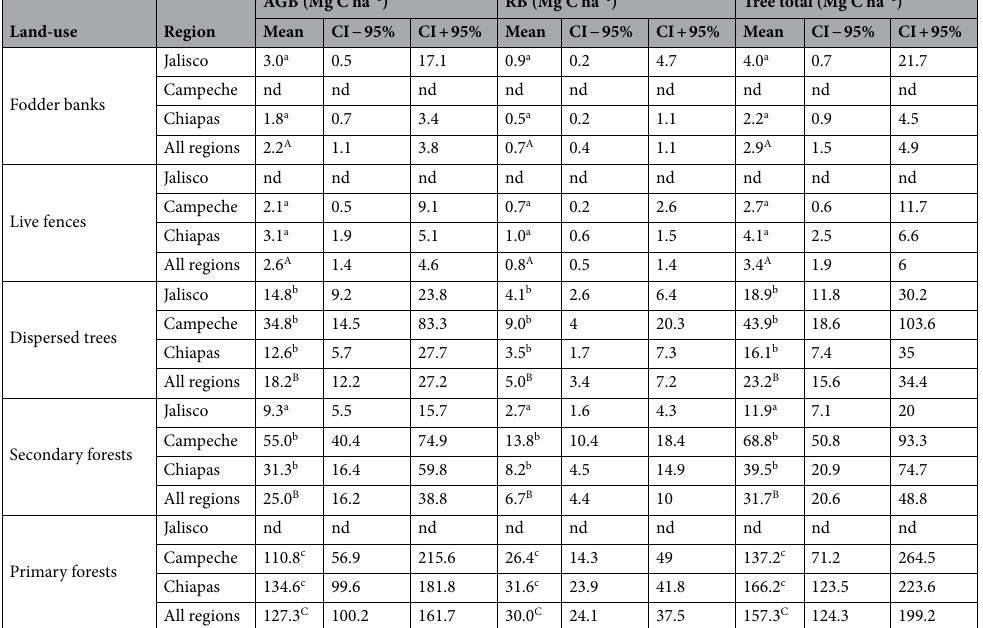
Table 2. Back-transformed weighted means and respective 95% confidence intervals of carbon stocks in above-ground biomass (AGB), root biomass (RB), and total tree biomass (Mg C ha −1 ) between different land- uses in three regions of Mexico. Tree total biomass: AGB + RB. Superscript uppercase letters indicate significant differences between land-uses, while lowercase letters indicate statistical differences between geographical regions (Tukey HSD, p < 0.05). nd data not